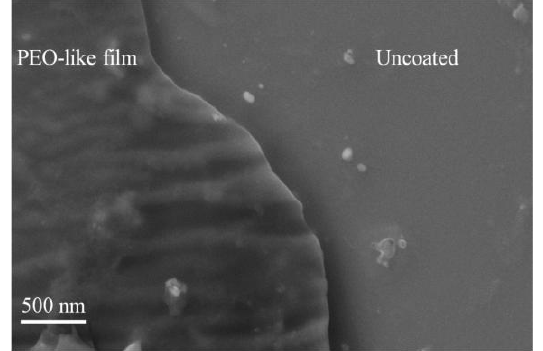
Figure 4. Surface morphology of the plasma polymerized PEO-like